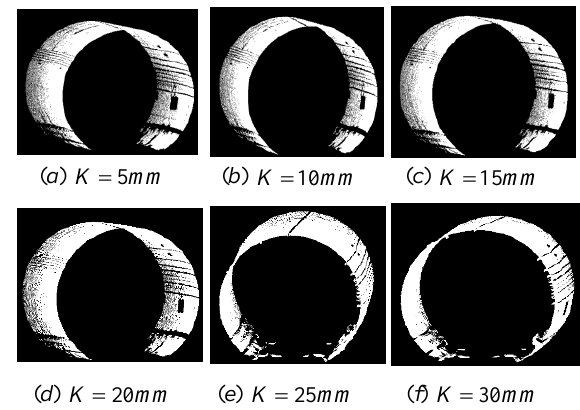
Fig.7 Filtering with different iterative parameters(d=1.0m)